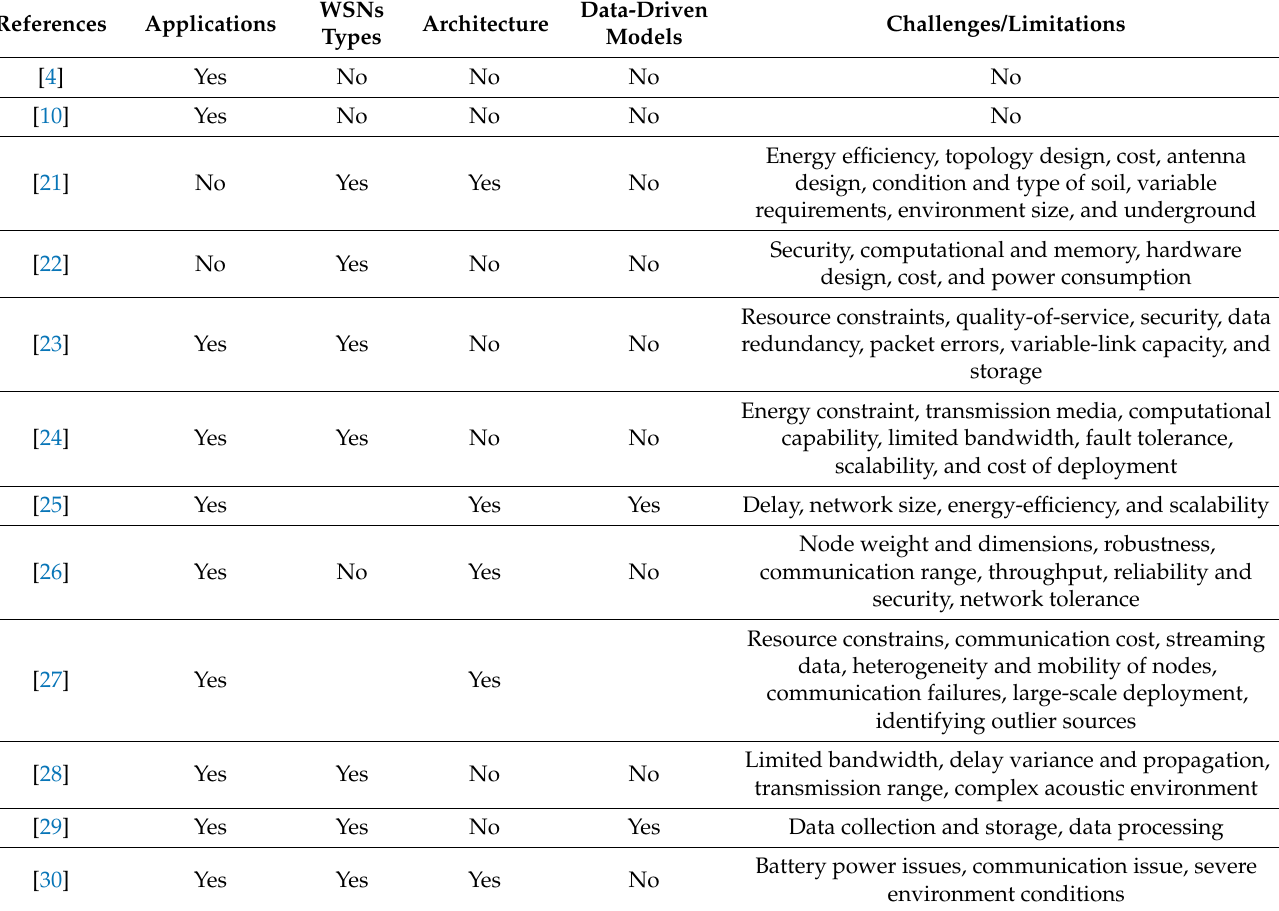
Table 1. Comparison of existing related works of data-driven models in